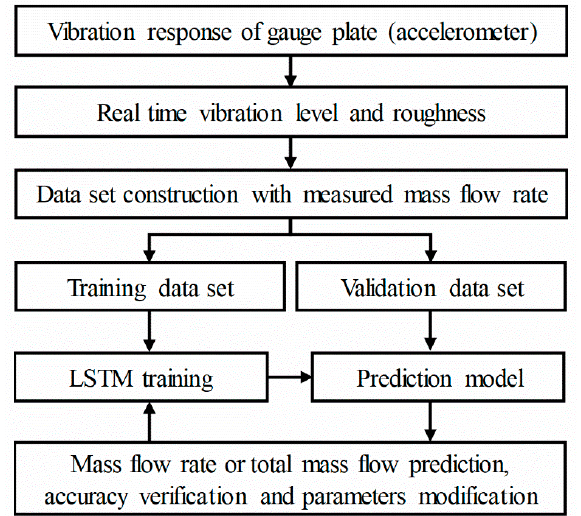
Figure 2. Framework of the proposed LSTM neural network for predicting the mass flow rate based on the vibration signals.